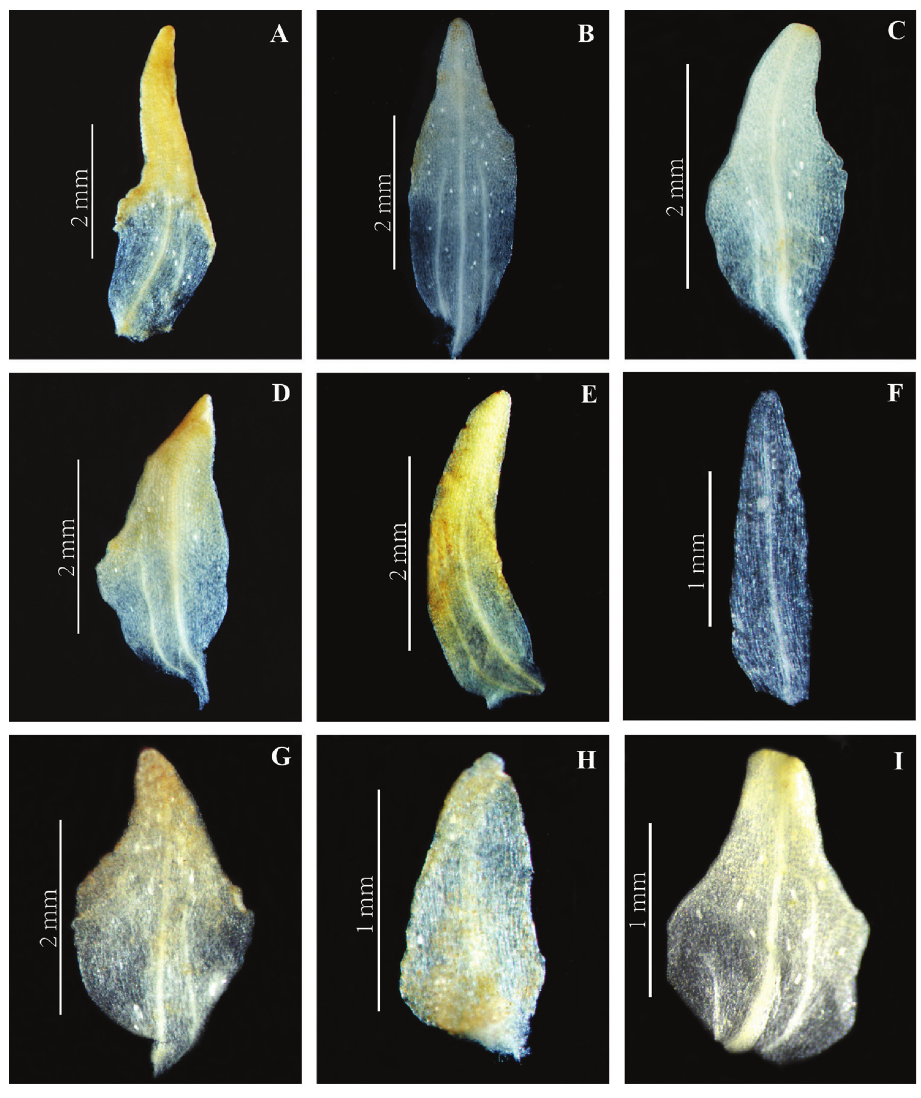
Figure 8. Petal of Herminium . A H. monorchis B H. chloranthum C H. pygmaeum D H. josephi E H. monophyllum F H. lanceum G H. josephi H H. coiloglossum I H. coeloceras.